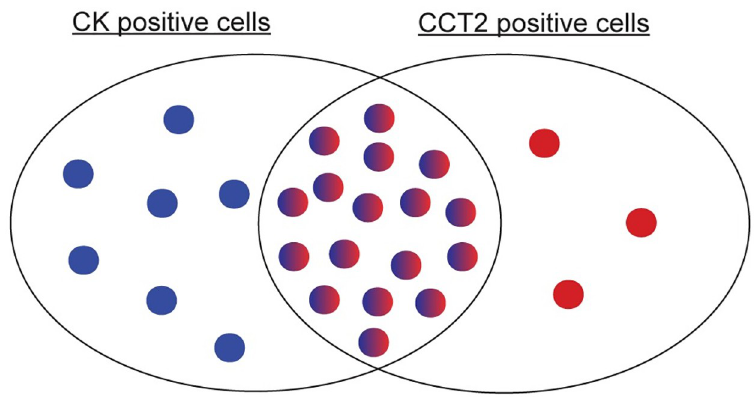
Fig 8. Venn diagram showing possible CTC subsets that are CK + /CCT2 - , CK + /CCT2 + , and CK - /CCT2 + .